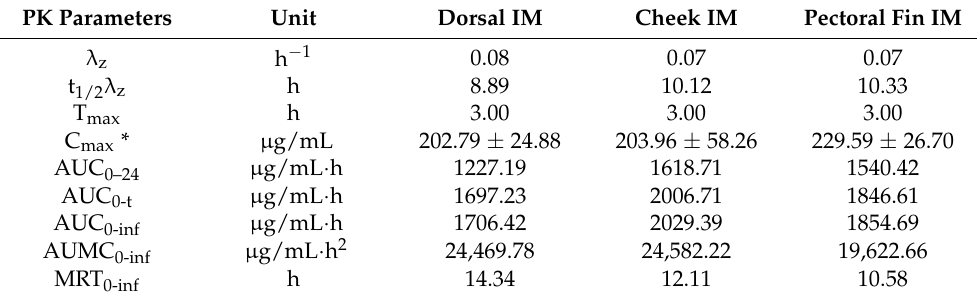
Table 1. Pharmacokinetic parameters of amoxicillin in serum of olive flounder ( Paralichthys olivaceus ) following intramuscular (dorsal, cheek, and pectoral fin) injection at a dosage of 40